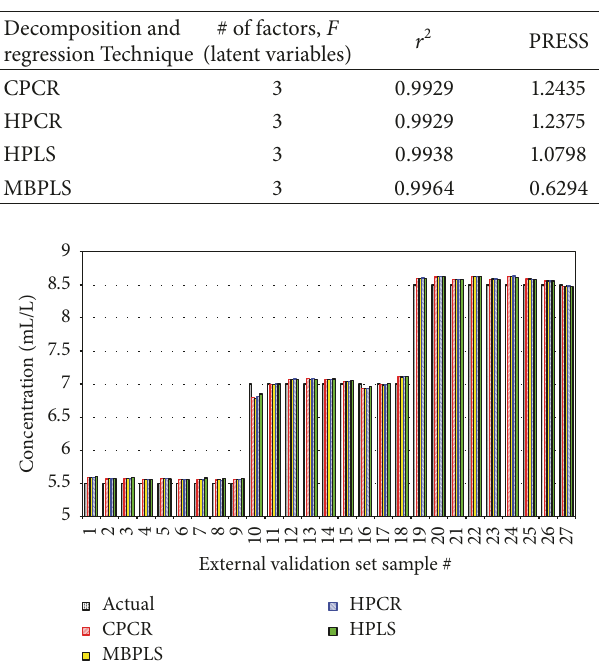
Figure 9: Actual (black) and predicted with CPCR (red), MBPLS (yellow), HPCR (blue), and HPLS (green) concentrations of sup- pressor for external validation set for 𝐹 = 2